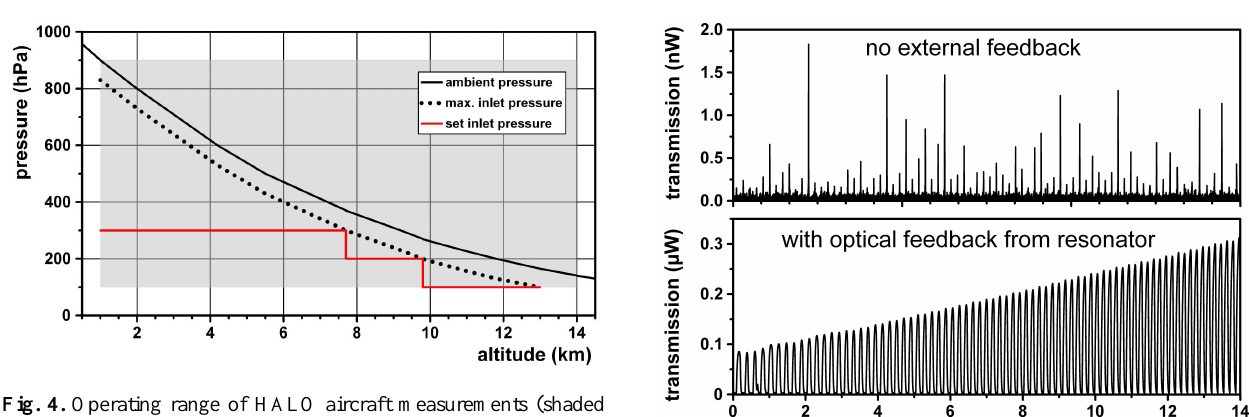
Fig. 4. Operating range of HALO aircraft measurements (shaded area). Maximum inlet pressure is assumed to be always 70hPa lower than ambient pressure. The proposed set inlet pressure is shown in red. For an inlet pressure of 100hPa the reactor flow must be reduced from 1 to 0.5sLpm.